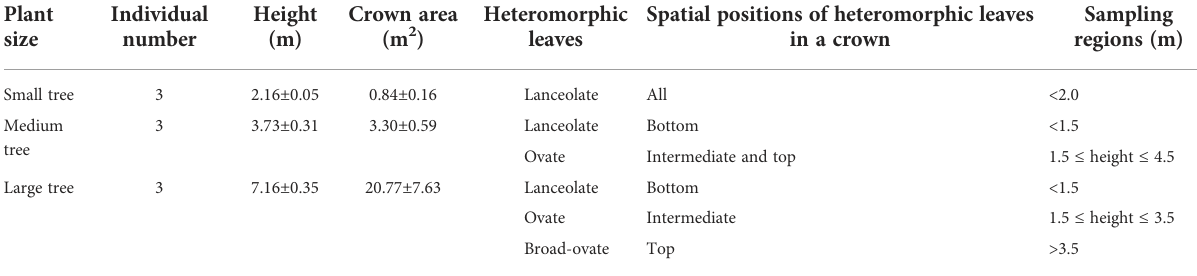
TABLE 1 Differences in vertical distributions and sampling regions among the three types of heteromorphic leaves.